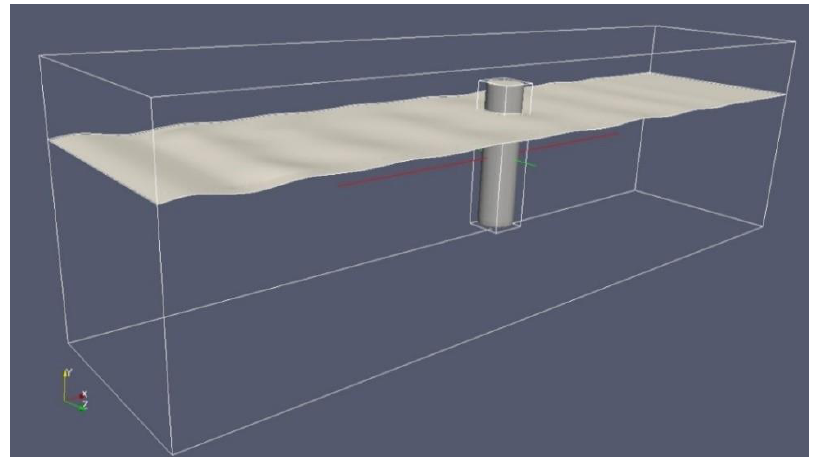
Figure 4. General assembly of the simulation domain.